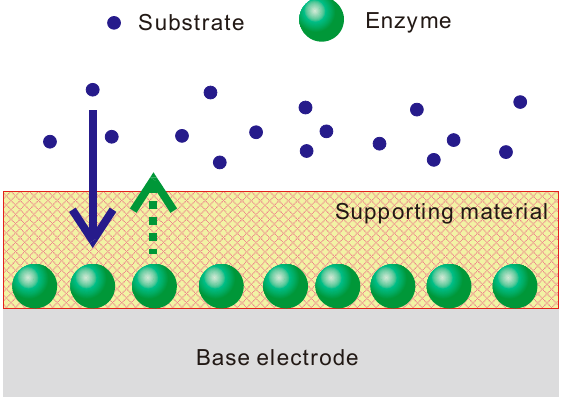
Figure 3. Schematic illustration of covered type-immobilization of the enzyme layer. Supporting material should prevent enzyme leakage and penetrate the substrate—i.e., if a polymer is used as the supporting material, mesh size of the polymer network should be greater than the enzyme substrate and smaller than the immobilized enzymes.